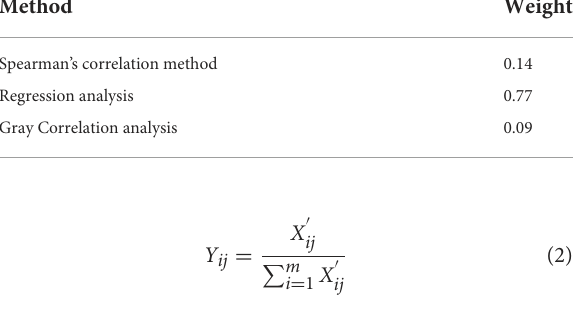
TABLE 2 The weights for each